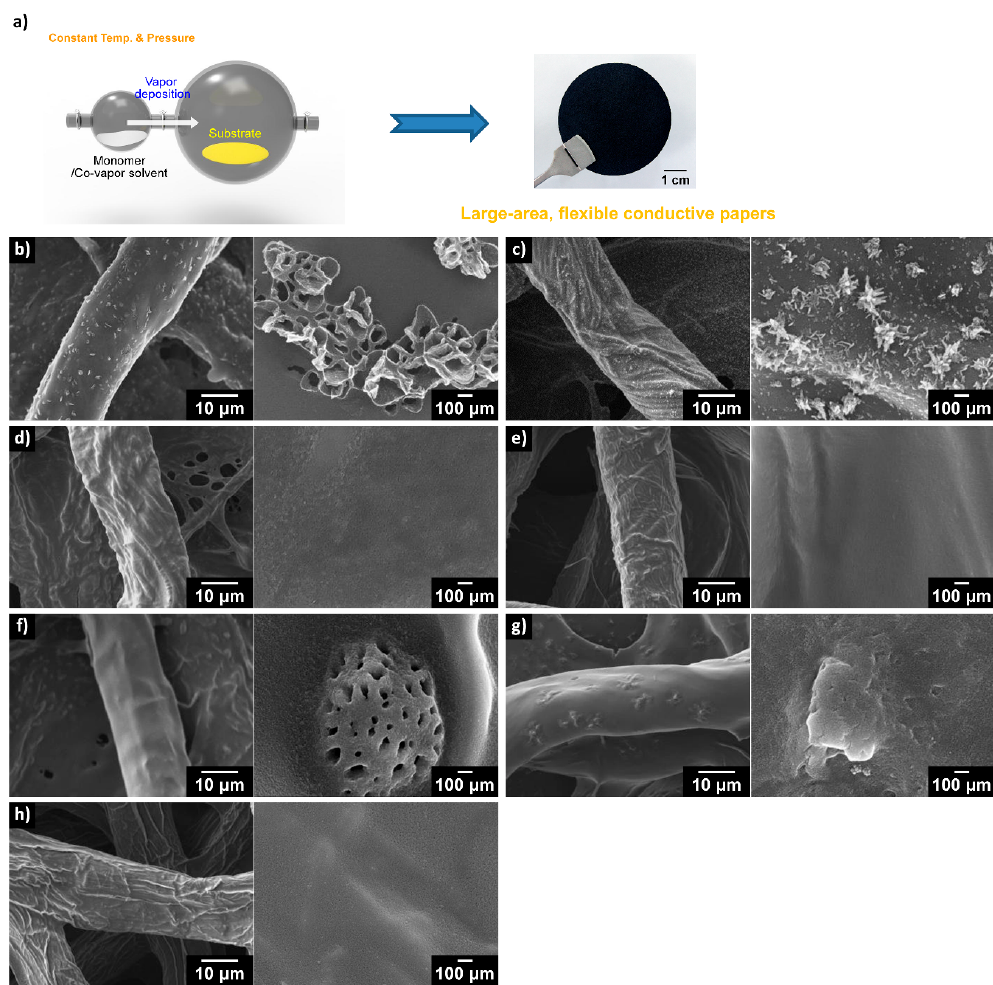
Figure 8. ( a ) Vapor-phase polymerization (VPP) of pyrrole with co-vapors on a cellulose substrate